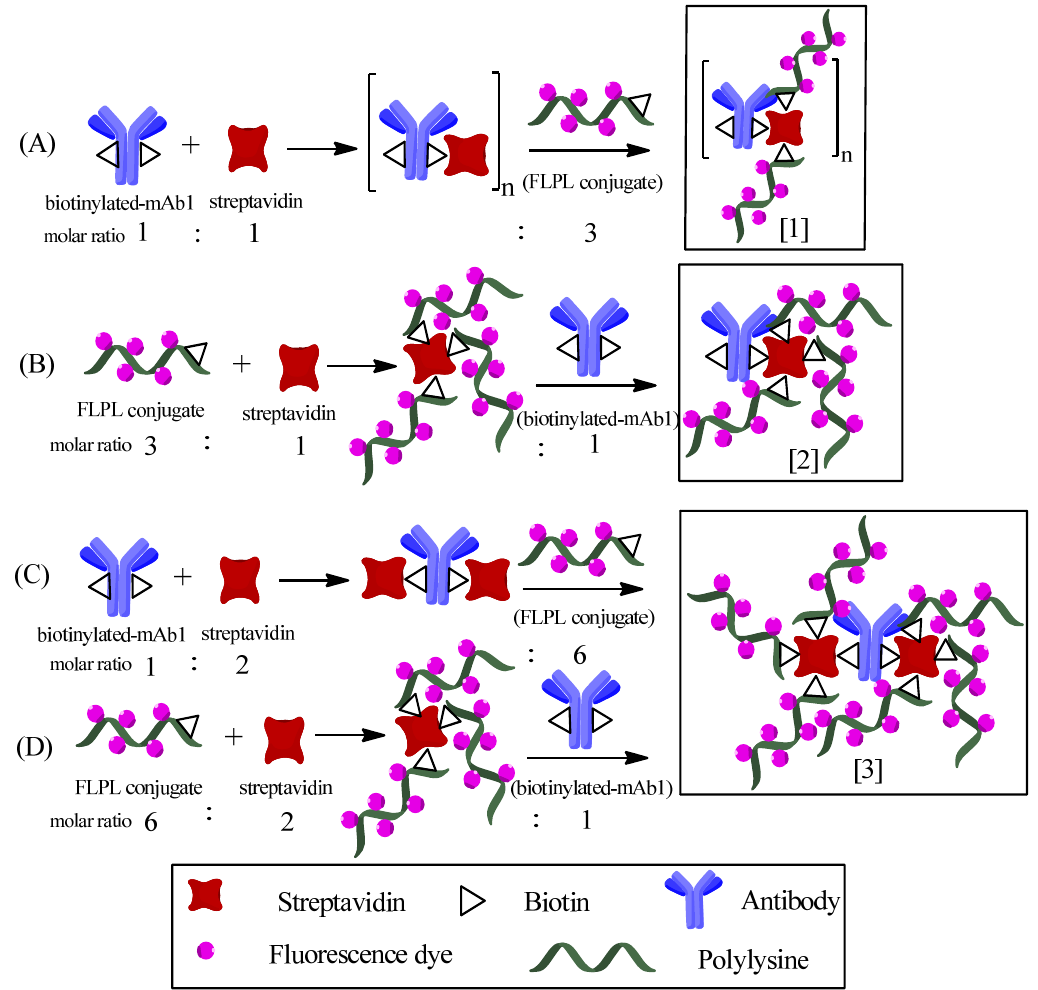
Figure 4. Chemical structures of various FLPL-BSAS-mAb1